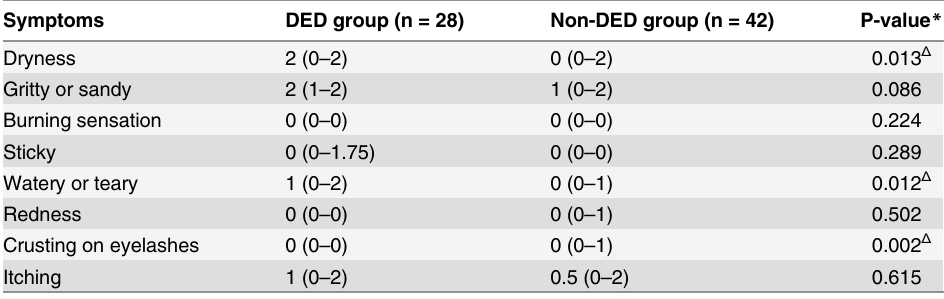
Comparison of ocular surface signs and symptoms in the study group members with and without DED In the study group, the data related to DED diagnoses are shown in Table 5. The patients with DED were significantly different from the patients without DED in both TFBUT ( P < 0.001) and corneal staining ( P < 0.001). The patients in the DED group were more likely to report dryness ( P = 0.013) and watery or teary eyes ( P = 0.012) (Table 6). No significant differences were identified between the groups in the other symptoms. Table 6. Ocular surface symptoms in the DED and non-DED groups.